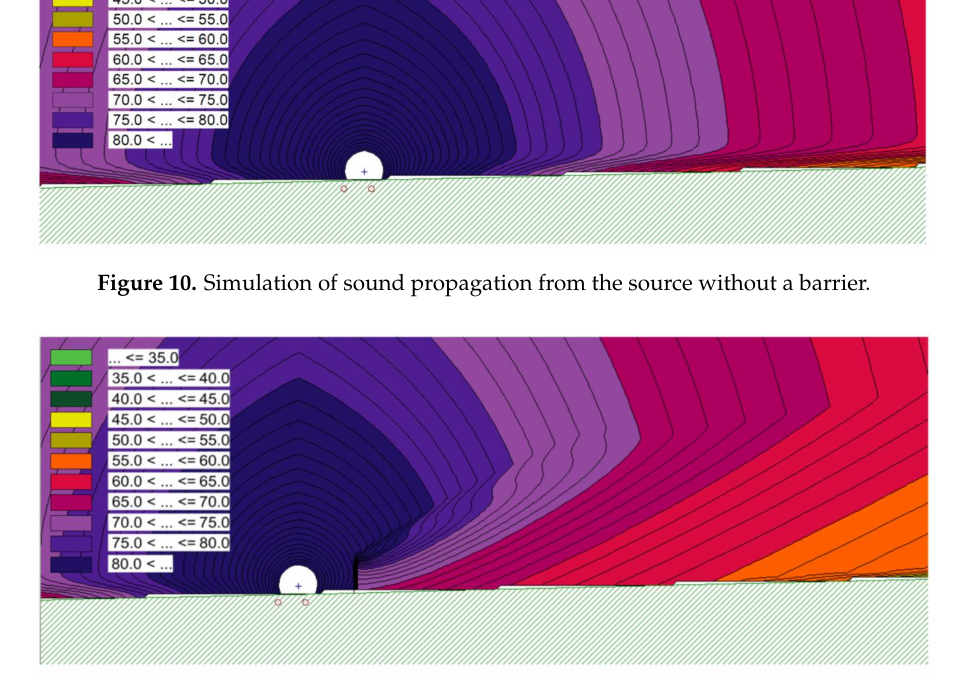
Figure 11. Simulation of sound propagation from the source with a barrier (distance of the barrier from the noise source was 5